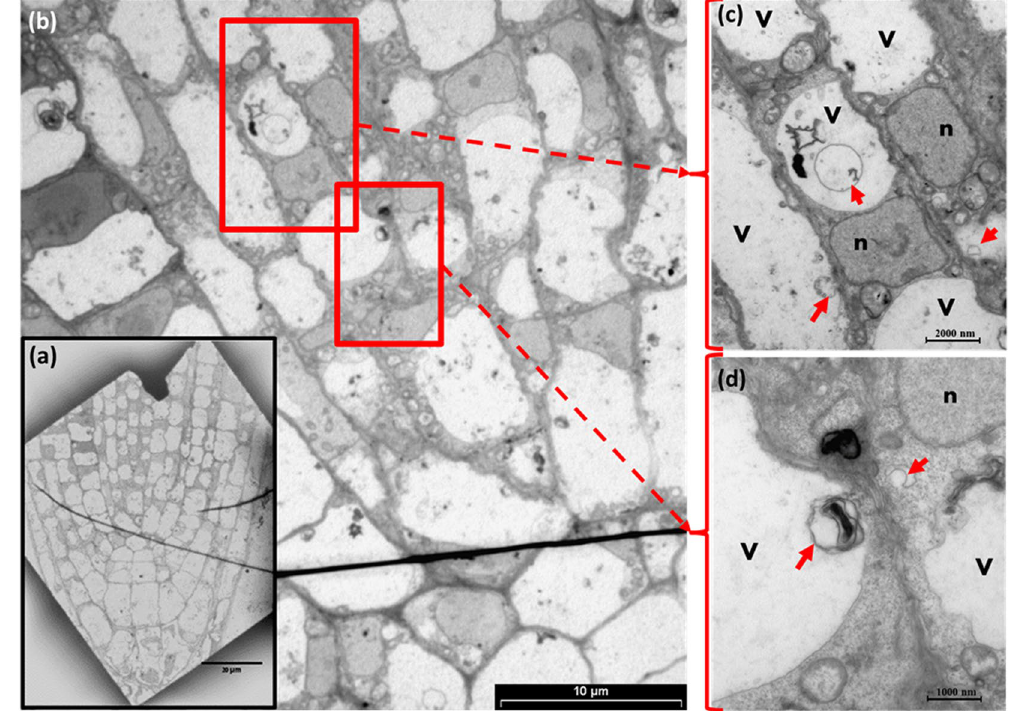
Figure 6. Ultrastructure Analysis of PR cells during lethal salinity. Arabidopsis plants were salt stressed (NaCl, 200 mM). ( a ) Representative TEM micrograph of stressed PR. ( b ) Is a zoom-in micrograph to the meristem core zone presented in ( a ), in which the presence of autophagosome like bodies can be visualized in the vacuoles and cytosol of these cells. ( c,d ) are the magnified regions of highlighted red boxes in ( b ) showing vacuolar and cytoplasmic localized membrane bounded autophagosome like structures. The letters ‘v’ and ‘n’ in ( c , d ) indicate the vacuole and nucleus respectively. Red arrows points to autophagosome like structures. Provided are images reflecting two biological